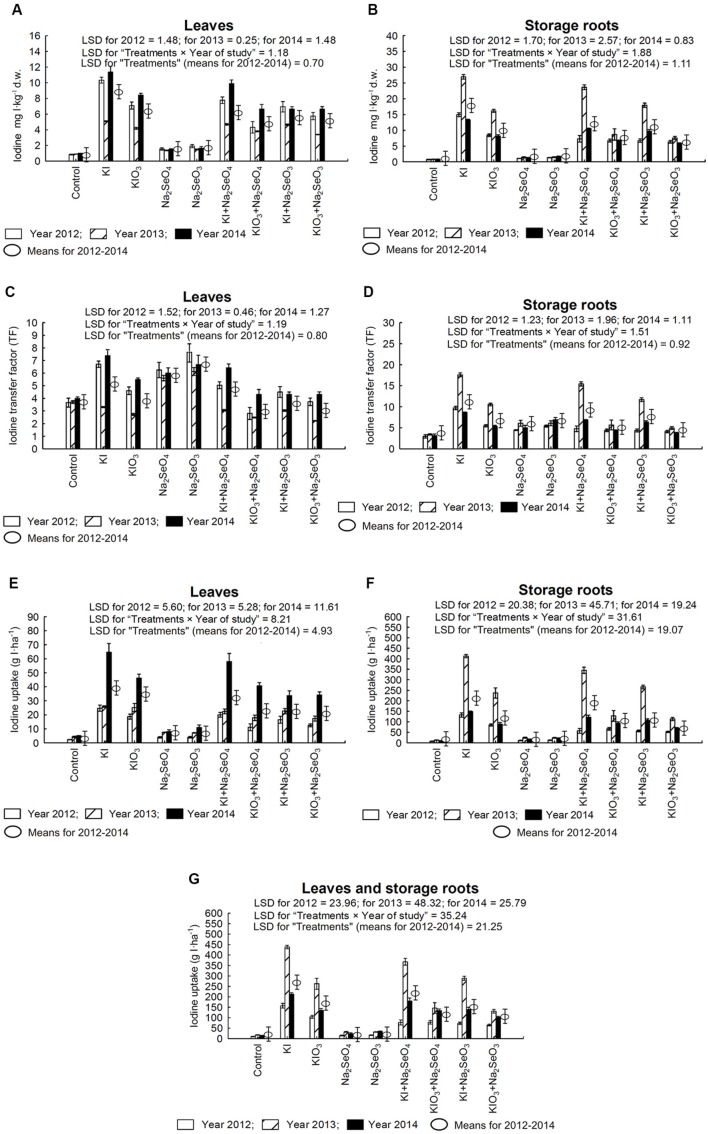
Iodine concentration in leaves (A) and storage roots (B), transfer factor (TF) of iodine to leaves (C) and storage roots (D) as well as iodine uptake by leaves (E), storage roots (F) and whole plants of carrot (G) in the years 2012–2014, depending on varying fertilization with iodine and selenium. LSD, least significant difference, p < 0.05. Bars indicate standard error; (n = 4).